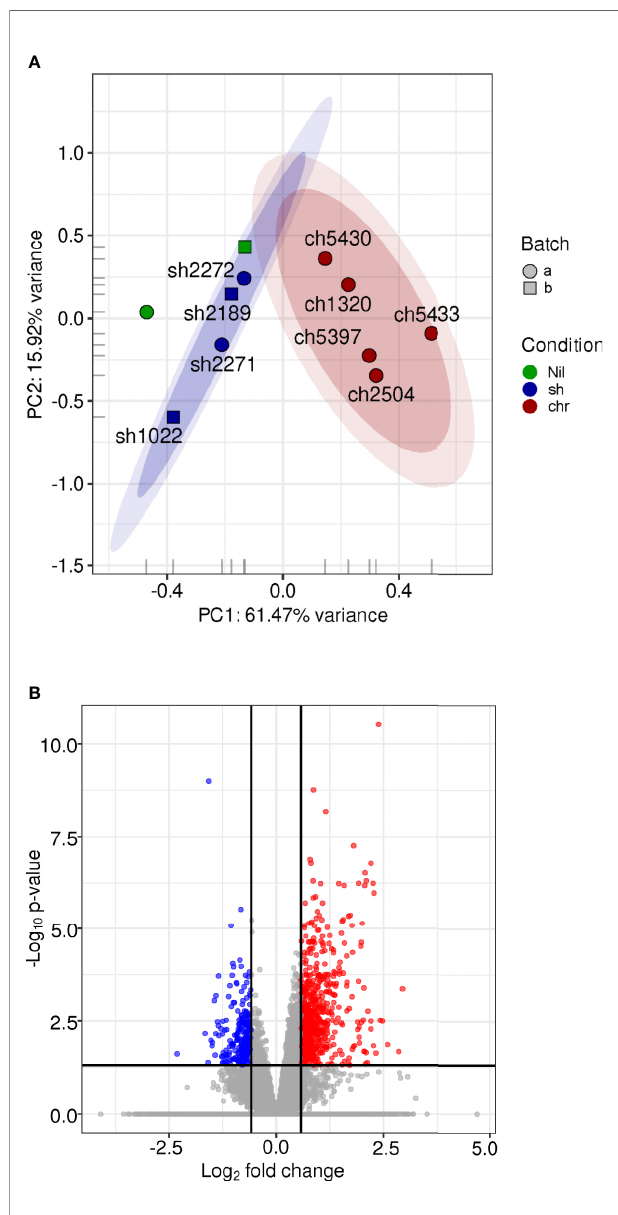
FIGURE 4 | Gene expression pro fi les of human macrophages infected with SH and CHR L. V. panamensis strains CL. The (H) sapiens RNA-seq expression data for annotated coding genes after low-count fi ltering (7,019 genes remaining) and log 2 [quantile(cpm)] normalization was examined via PCA (A) . Each glyph represents an experimental sample where the color represents the infection state, the shape represents the experimental batch. The 0.90, 0.95 con fi dence intervals are shown as shaded ovals. Differential expression analysis was performed using DESeq2, including experimental date (batch) in the statistical model. The volcano plot (B) shows the distribution of signi fi cance (-log adjusted P value) with respect to log 2 -fold change. Points colored in blue are deemed signi fi cantly downregulated in the macrophage samples infected with CHR vs. SH strains while those in red are signi fi cantly